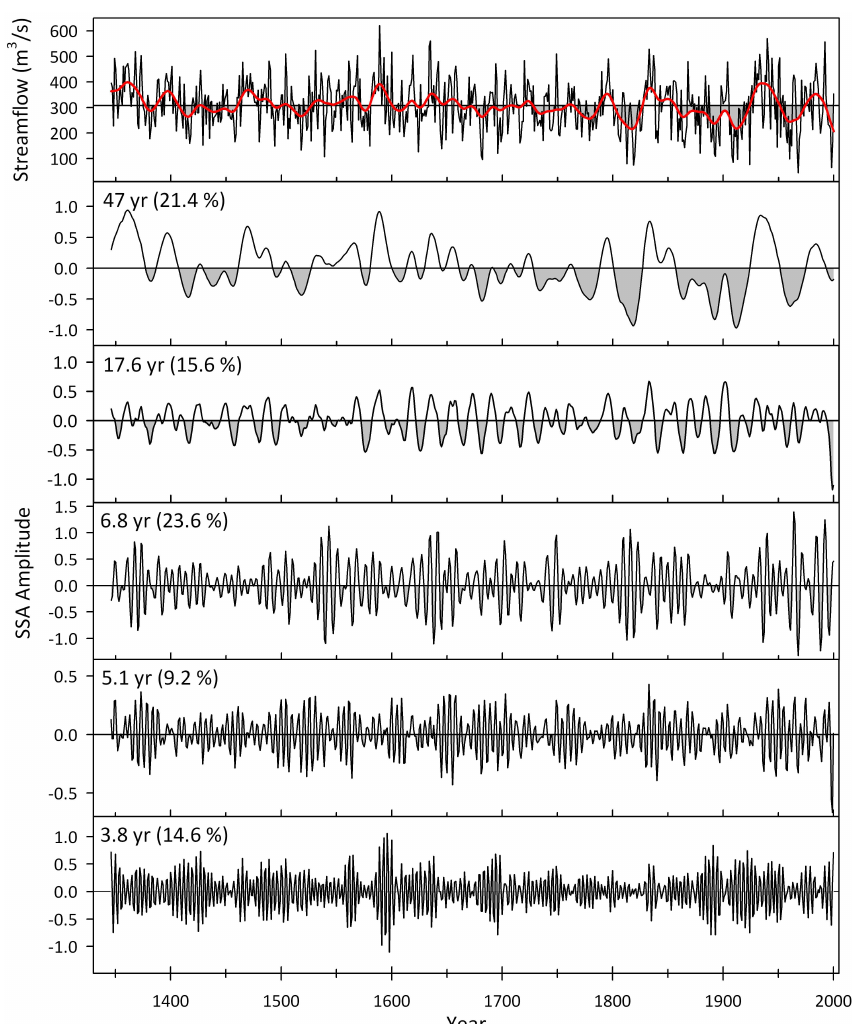
Fig. 7. The Neuqu´en River streamflow reconstruction (top panel) and its most significant oscillation modes estimated using singular spectrum analysis (SSA). Units are dimensionless. Periods in years and the percentage of variance associated with each waveform are shown in the upper-left corners of the streamflow